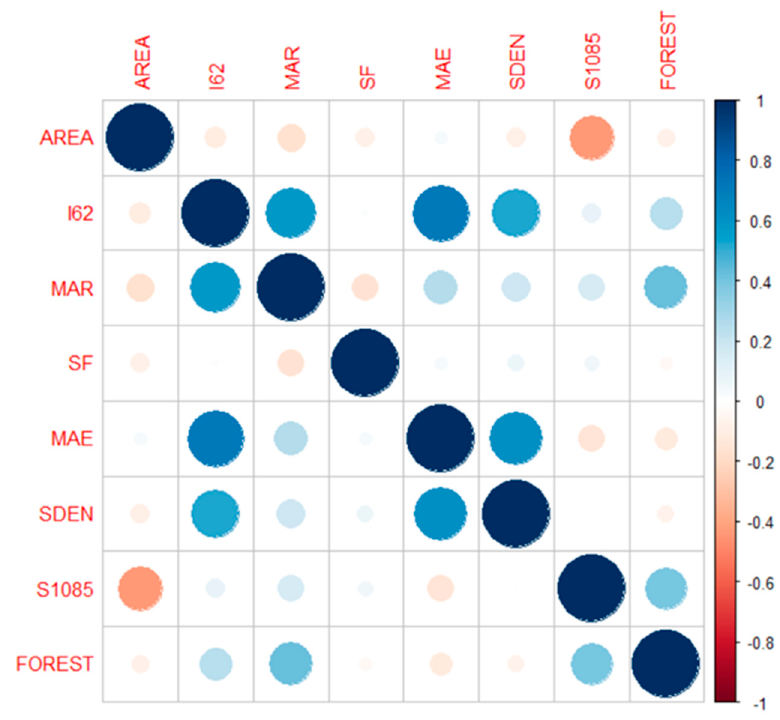
Figure 3. Correlations among eight candidate predictor variables.